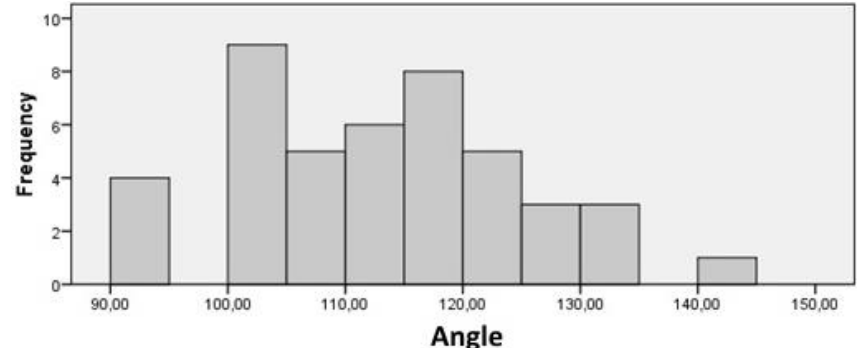
Figure 6. Debitage/core-flakes angles (platform/positive face) tendencies.